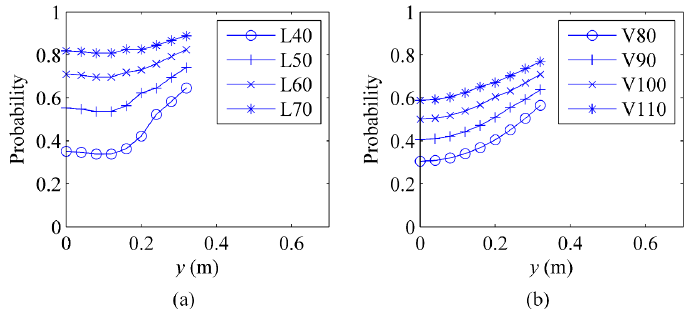
Figure 6. Results of the probability of being less than the target mechanical responses for ( a ) longitudinal tensile strain at the bottom of the asphalt layer and ( b ) vertical compressive strain on the top of the subgrade (L40, L50, L60, L70 = target longitudinal tensile strain is 40, 50, 60, and 70 µε , respectively; V80, V90, V100, V110 = target vertical compressive strain is 80, 90, 100, and 110 µε , correspondingly).